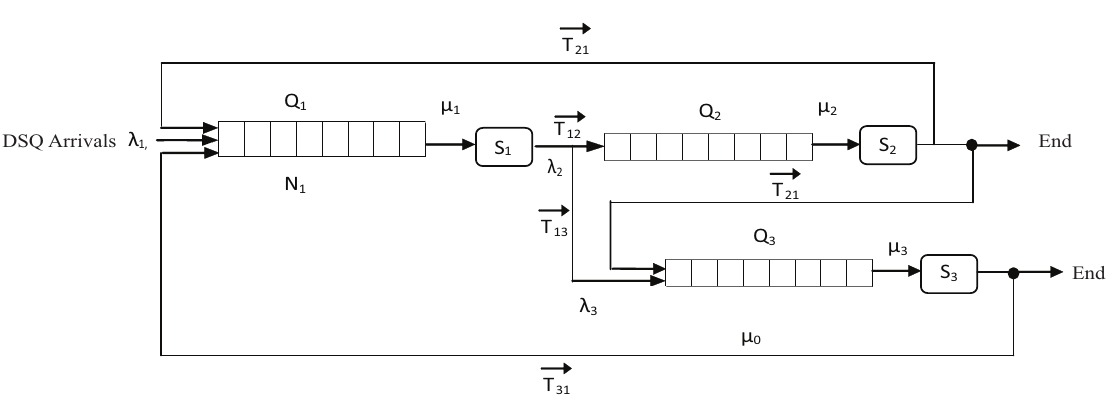
Figure 1. Resource allocation model with 3 resources, i = 1 is the dominant